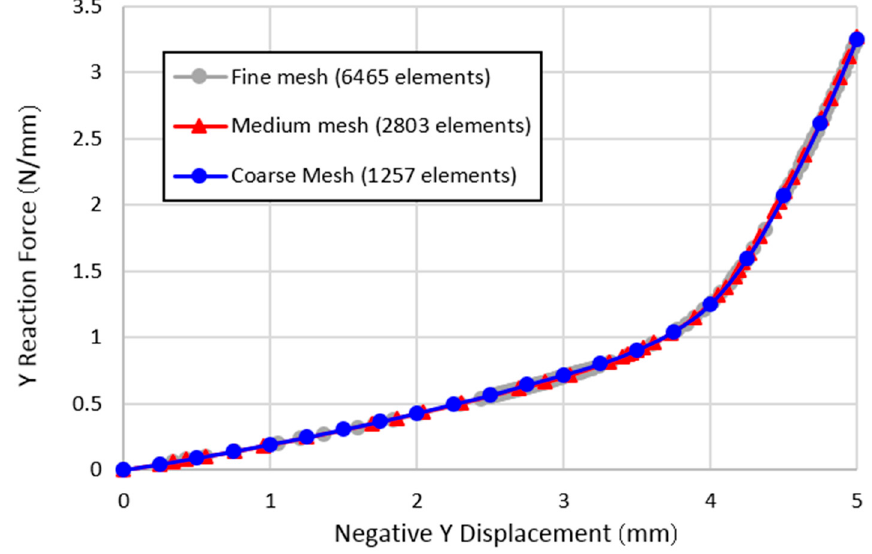
Figure 8. Y reaction force vs Negative Y displacement for three different mesh configuration.